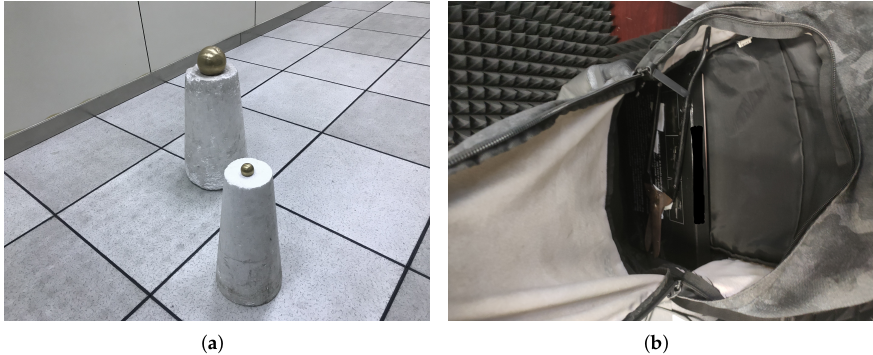
Figure 6. The experimental scenario. ( a ) The two spheres. ( b ) The snip.